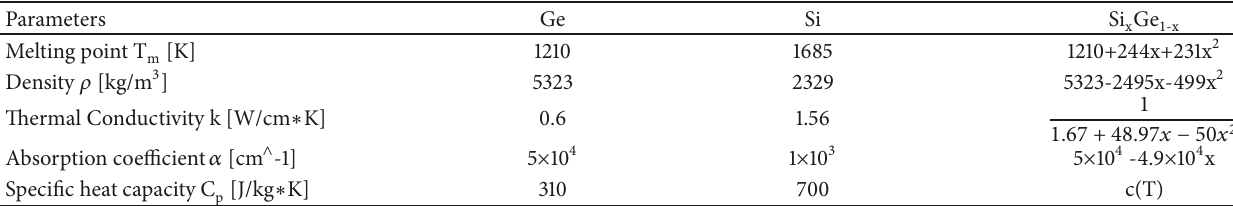
Table 1: Thermal parameters of the materials used for the numerical model